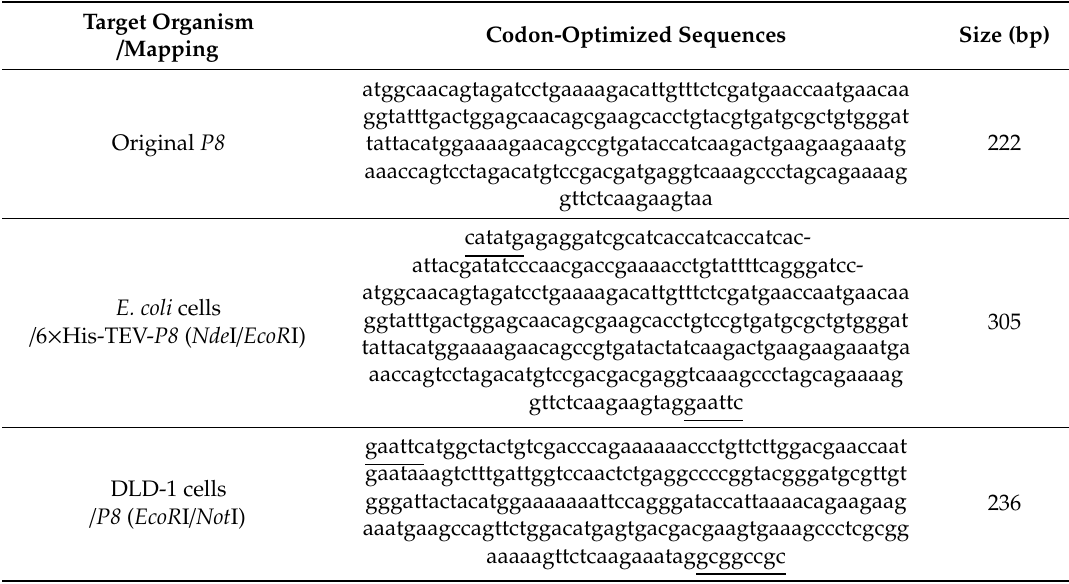
Table 1. List of codon-optimized p8 gene segments and target